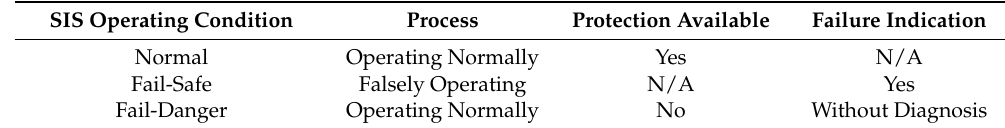
Table 2. Operating conditions of SIS.